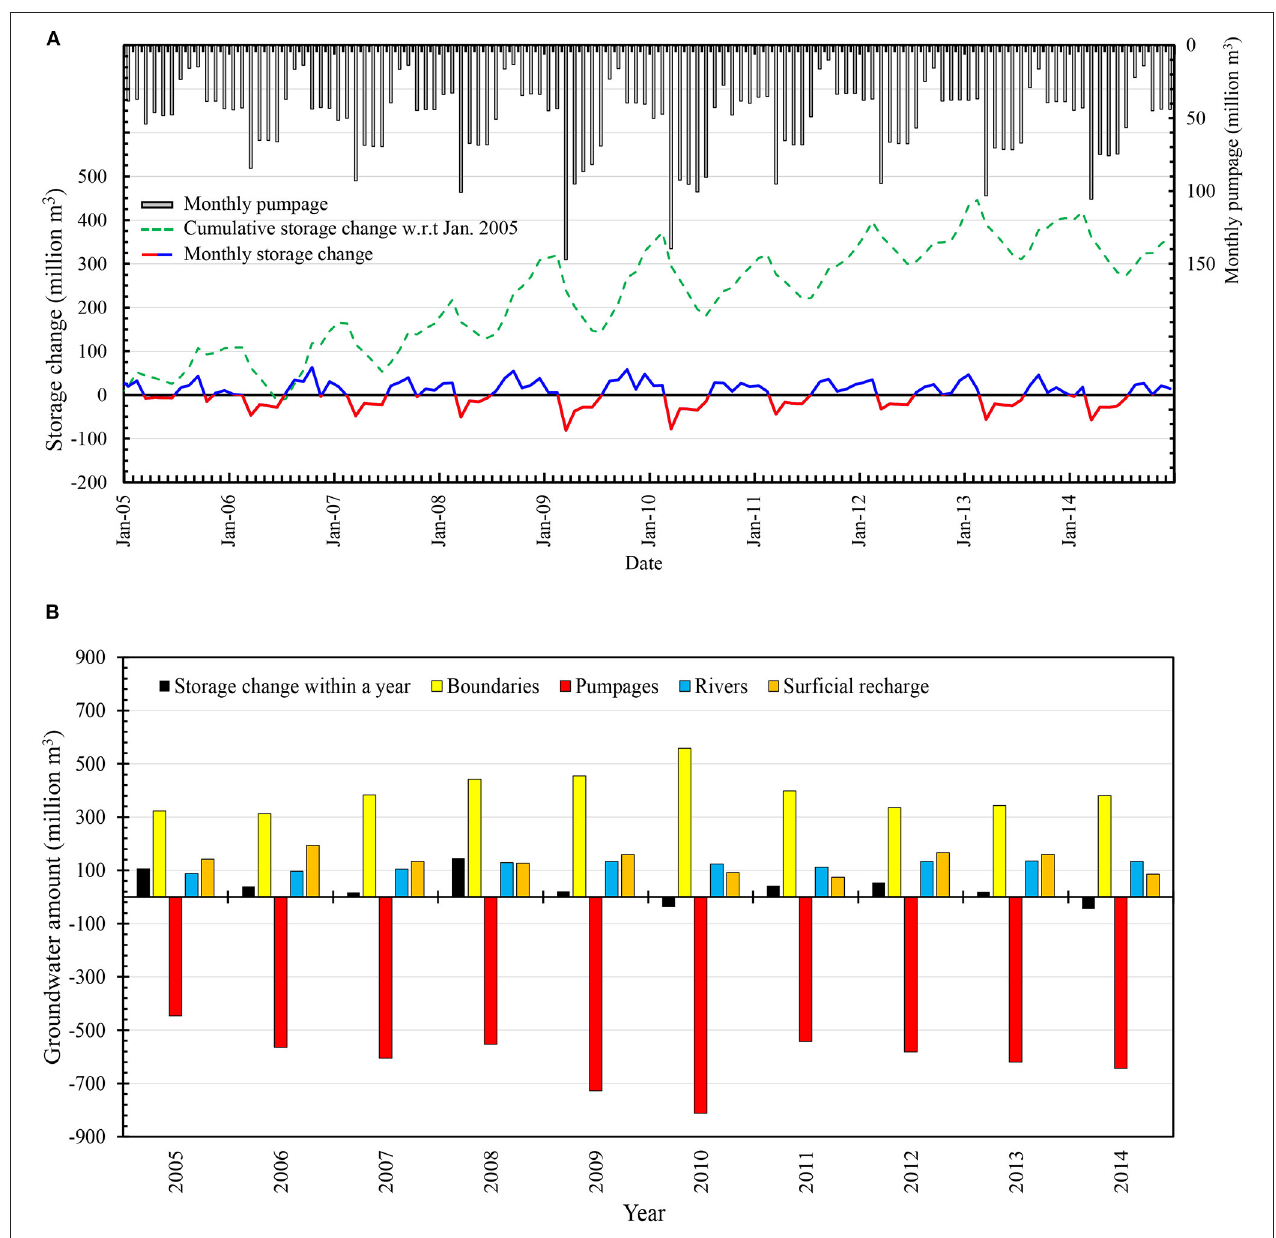
FIGURE 9 | Estimated groundwater budget for the Chicot aquifer system: (A) monthly pumpage (million m 3 ), monthly storage increase/decrease (million m 3 ), and cumulative groundwater storage change (million m 3 ) with respect to January 2005, and (B) annual net groundwater inflow/outflow (million m 3 ) from the model boundaries, the pumping wells, the rivers, and the surficial recharge along with annual groundwater storage change (million m 3